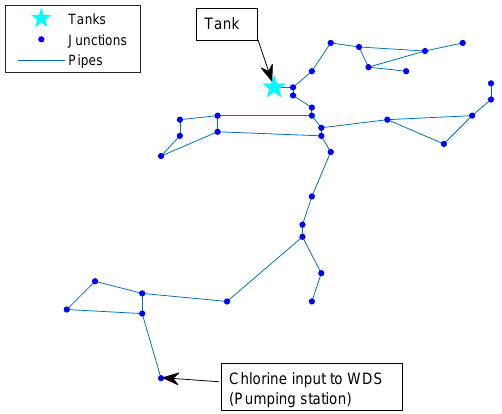
Figure 3. WDS under